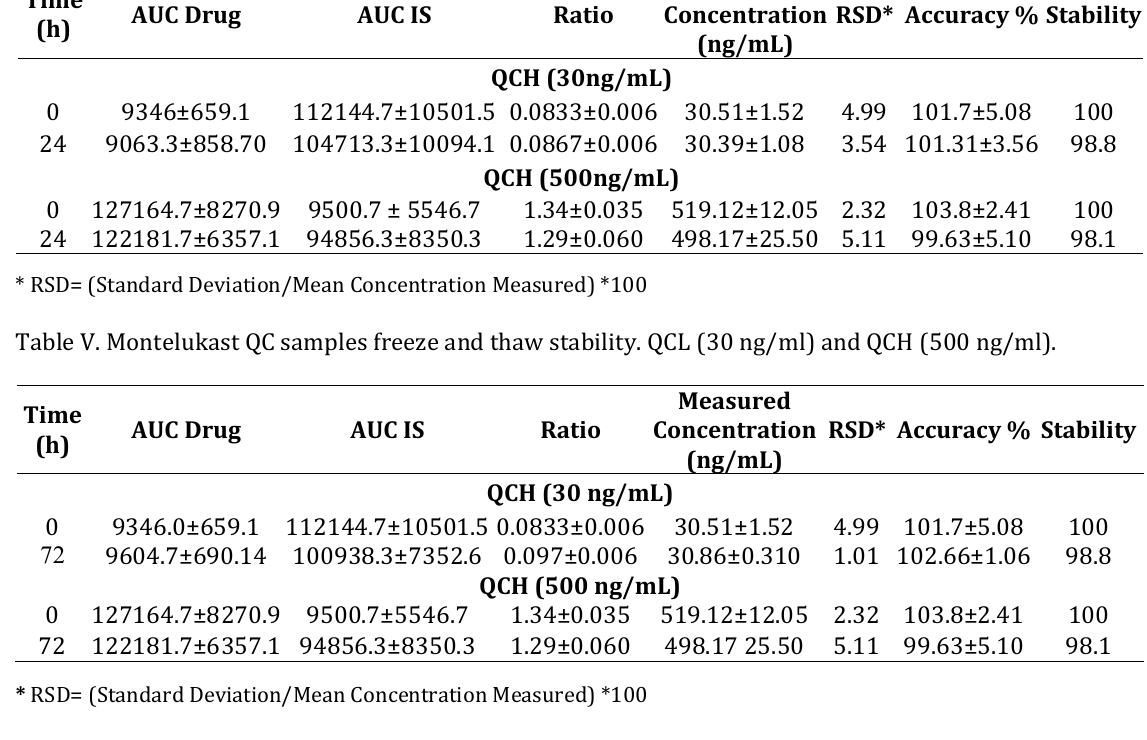
Table VI. Pharmacokinetic data of